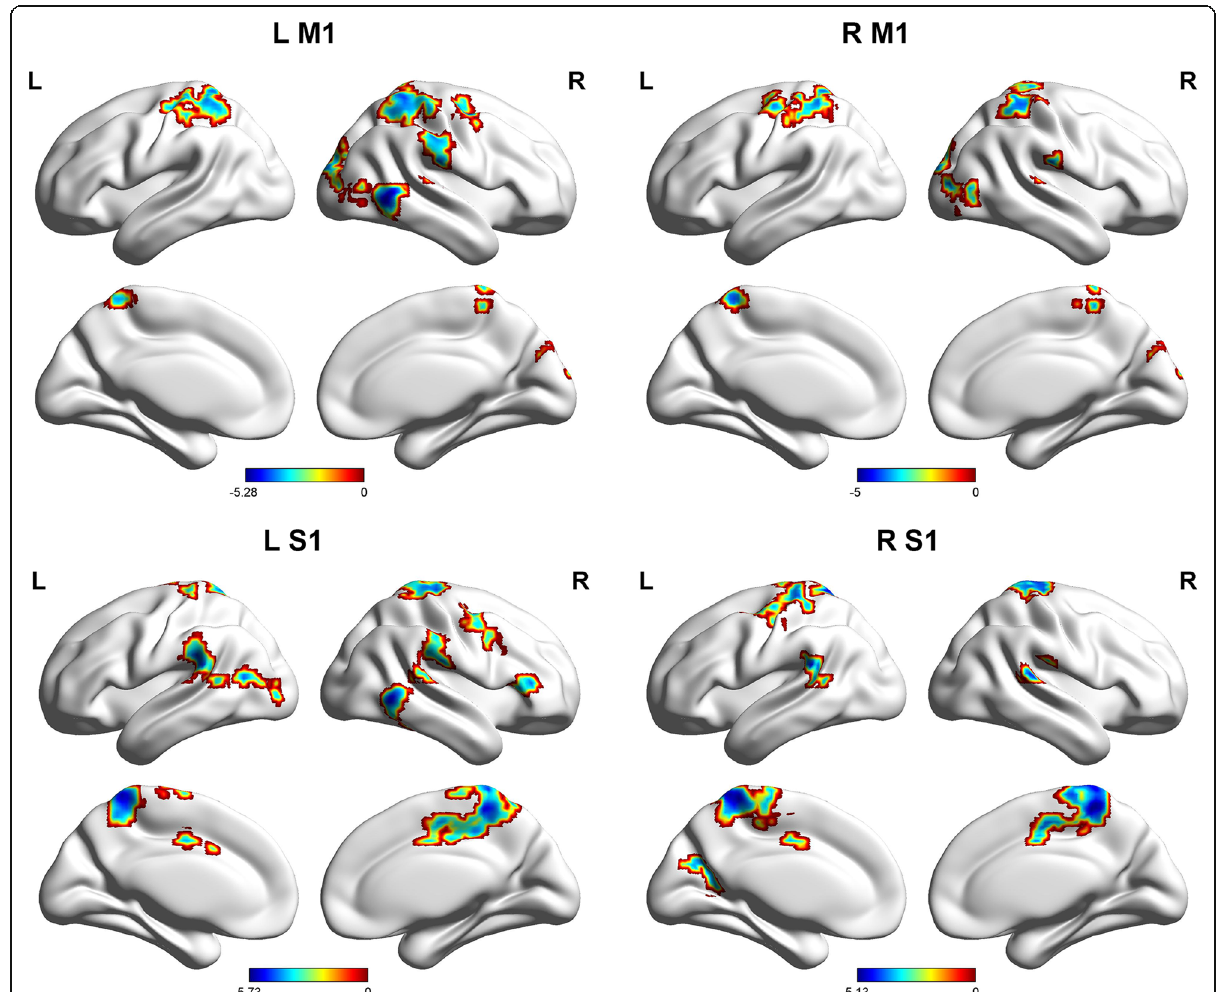
Fig. 1 Sagittal views of the MNI brain areas showing reduced intrinsic functional connectivity (FC) with the M1 and S1 in MWoAs compared to healthy controls. The surviving clusters were assigned thresholds at p < 0.001 (voxel level) and were FWE corrected to p < 0.05 at the cluster